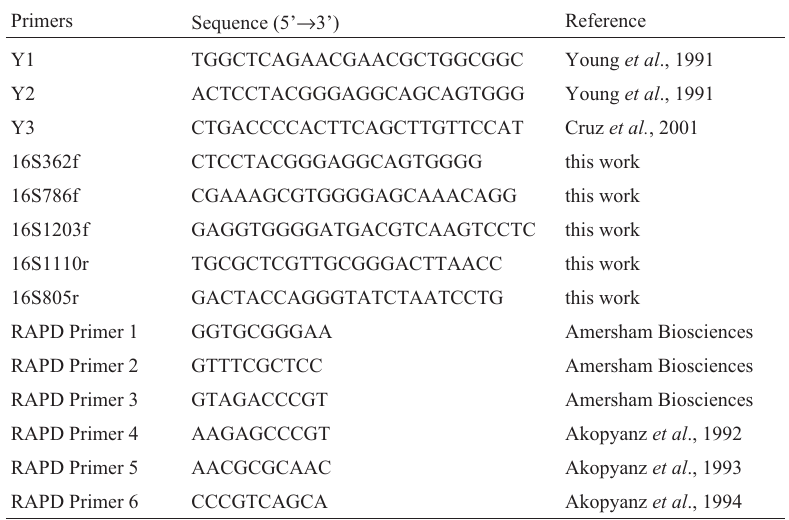
Table 1 - Sequences of the primers